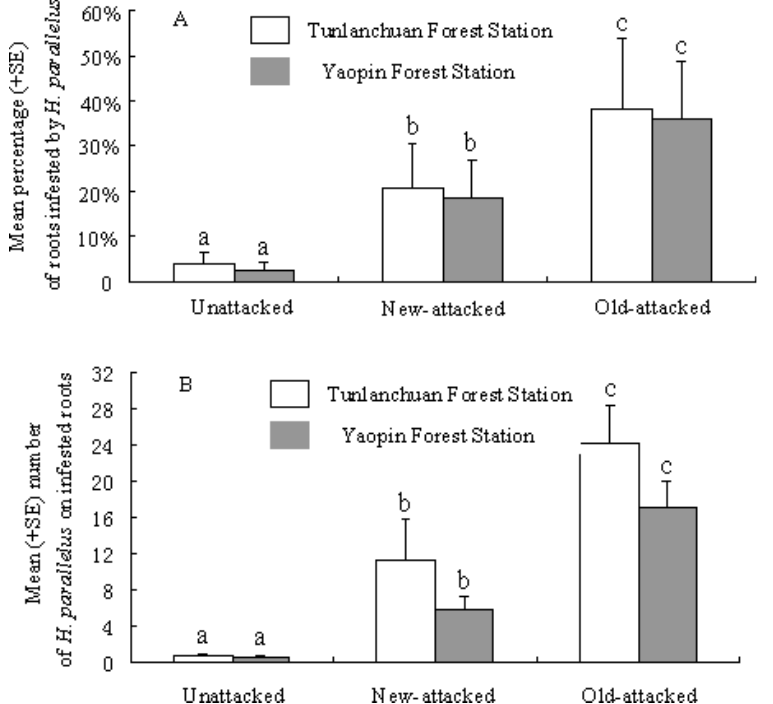
Figure 1. Field association between D.valensand H.parallelus. Percentage of roots infested by H. parallelus (A) and average number of H. parallelus on each infested pine root (B) for pine trees unattacked by D. valens , newly-attacked by D. valens , and old-attacked by D. valens at two experimental sites in China ( n =10).